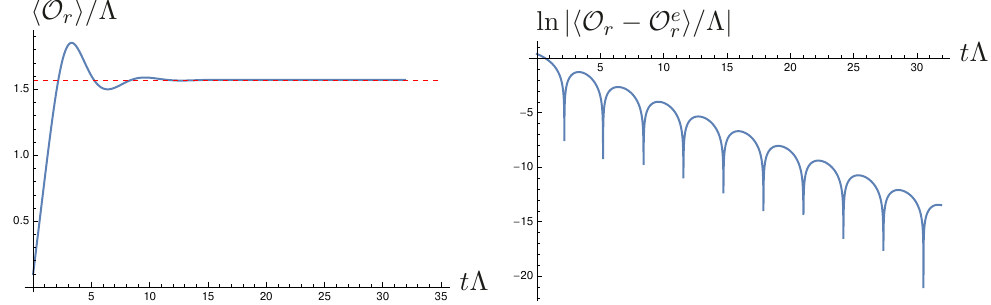
Figure 10 . Typical relaxation in Z 2 symmetric sector of sBBL model. The expectation value of operator (dual to the bulk scalar φ ) settles to its equilibrium value O r line (left panel). Right panel shows a characteristic QNM ring-down of the expectation value to its equilibrium